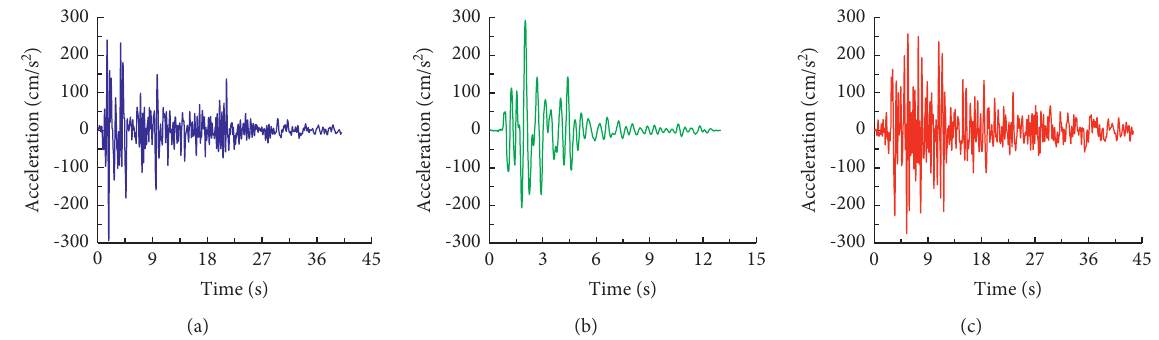
Figure 11: Loading earthquake waves. (a) El Centro wave. (b) Kobe wave. (c) Taft wave.